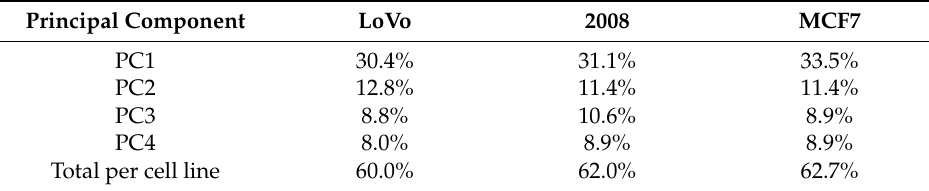
Table 4. Principal component